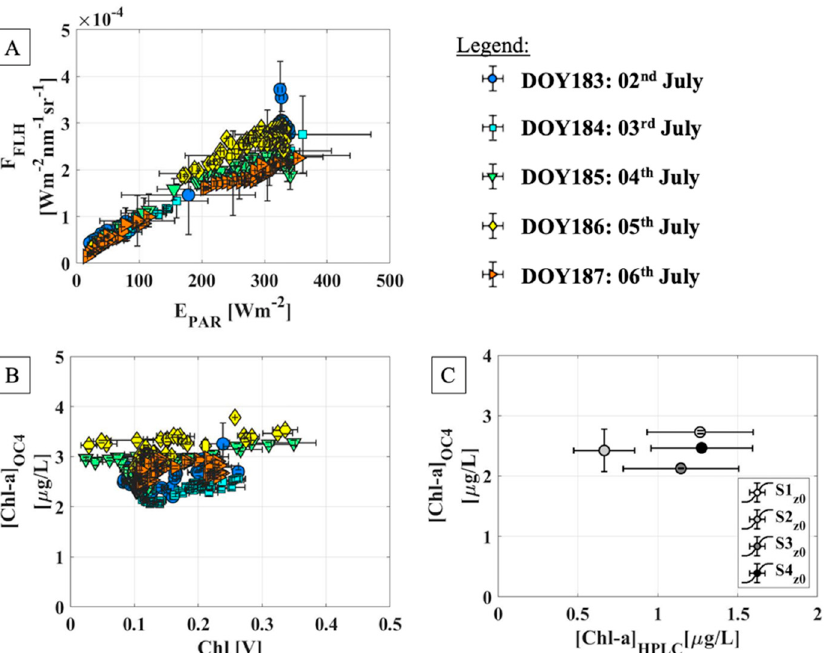
Figure 8. ( A ) shows the comparison between E PAR and F FLH throughout the time series. Each days of observation is characterized by different symbols and colors displayed in the legend on the top right. ( B ) collects the two chlorophyll concentration parameters: on the x axes there are the fluorom- eter values (in Volt), while on the y axes the spectral index is evaluated from the reflectance exploit- ing the OC 4 approach. Furthermore, ( C ) shows the comparison between the [Chl-a] values obtained from the laboratory analysis and the spectral measurements.